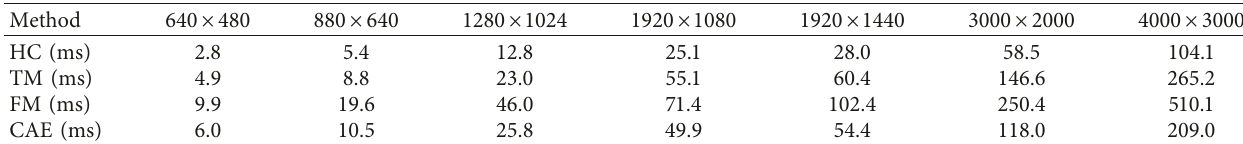
Table 3: Inspection time for CAE and image similarity comparison